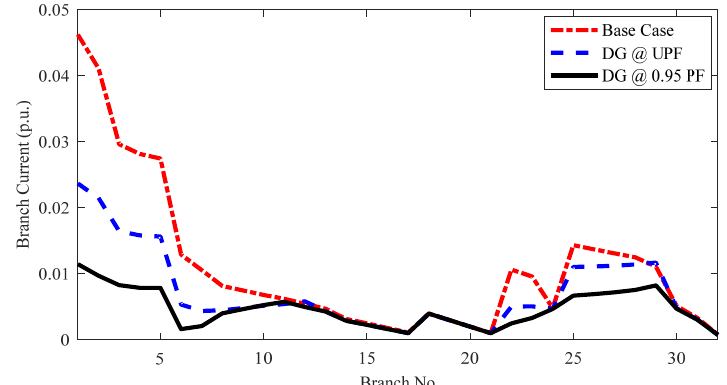
Figure 7 Branch current profile of the 33-bus test system for scenario IV. Figure 7. Branch current profile of the 33-bus test system for scenario IV.